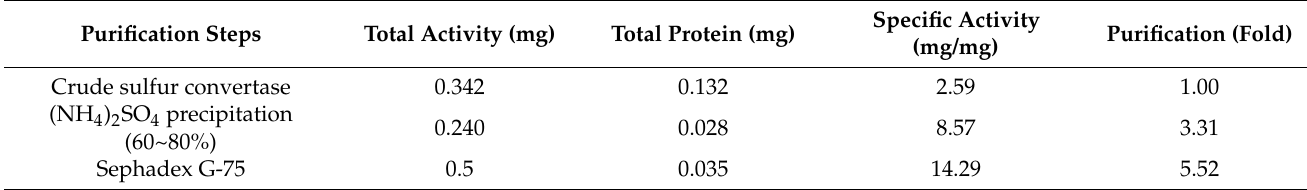
Table 2. Steps of the purification of sulfur